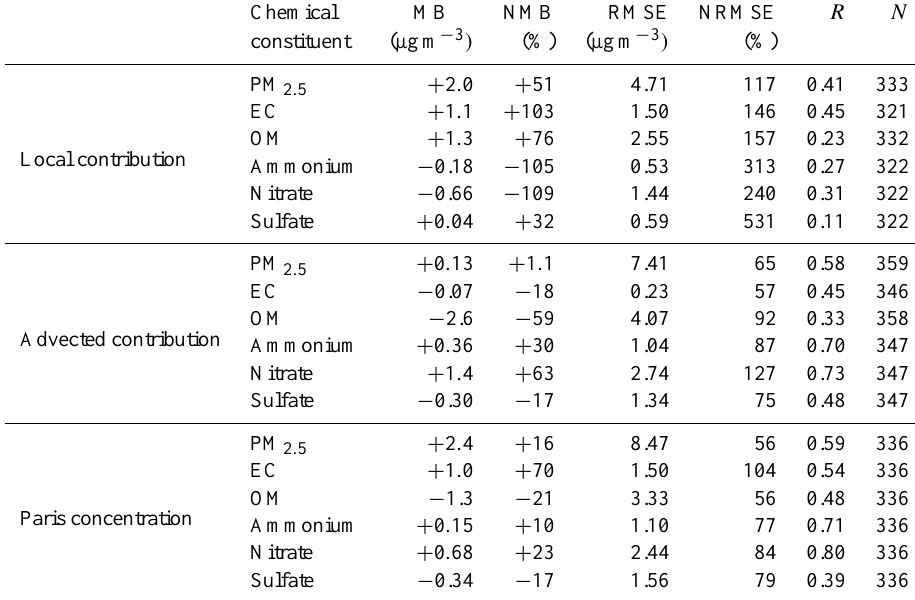
Table 7. Statistical results for local and advected contribution and urban background concentration (see metrics definitions in Sect. 4.2, N is the number of daily